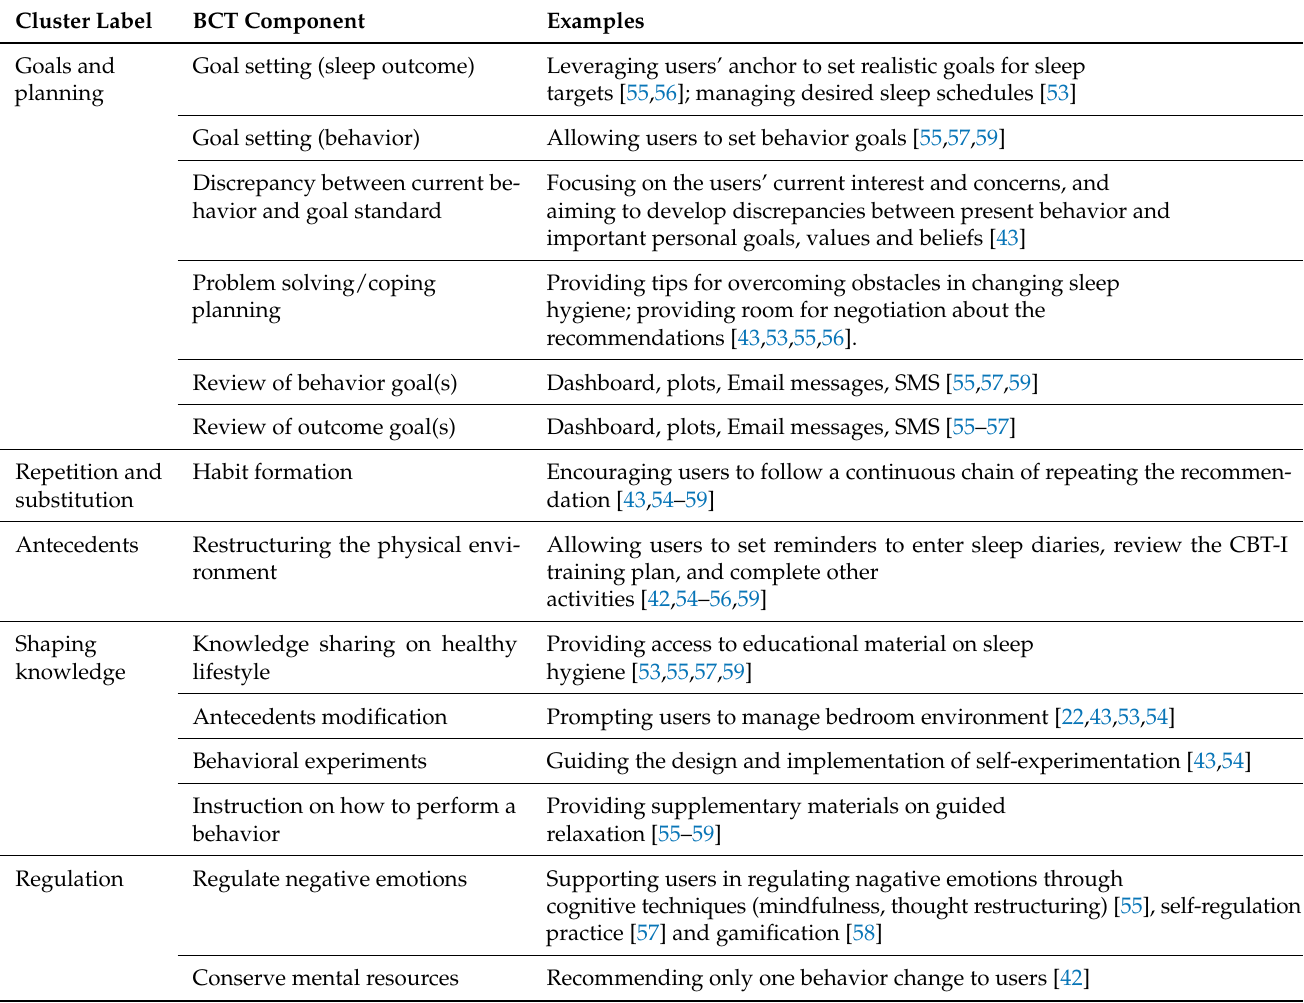
Table 5. BCTs focusing on behavior interventions before sleep (Category-I